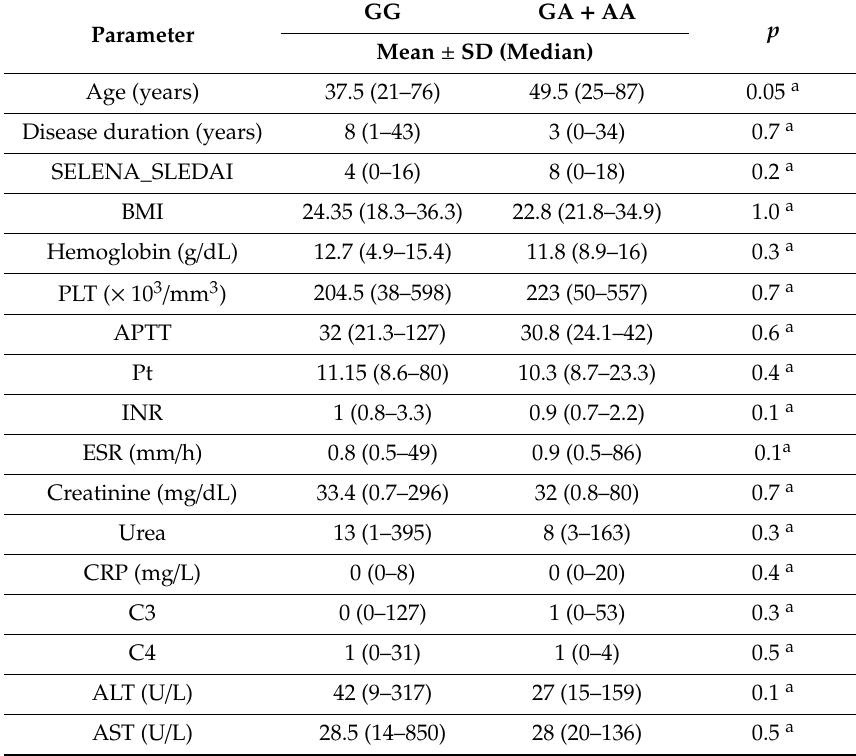
Table 3. Disease activity and laboratory variables in relation to MECP2 rs2075596 G / A, dominant